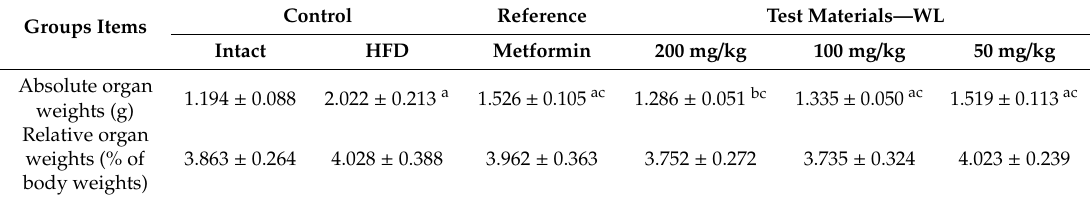
Table 10. Changes in absolute and relative liver weight in NFD or HFD supplied